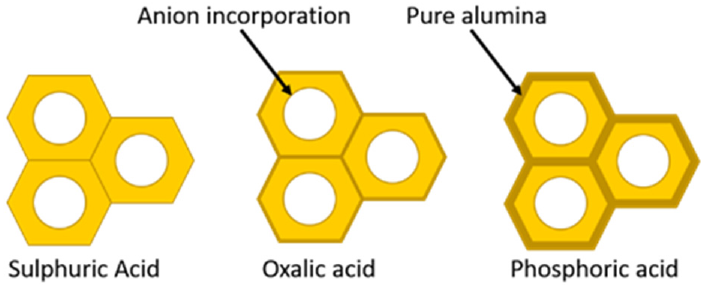
Figure 6. Schematic representation of the duplex pore wall structure characterized by the inner and outer pore cell structure depending on the anodized electrolyte: Sulfuric acid, Oxalic acid and Phosphoric acid. The thickness of the inner layer varies depending on the kind of electrolyte used during the anodization process.